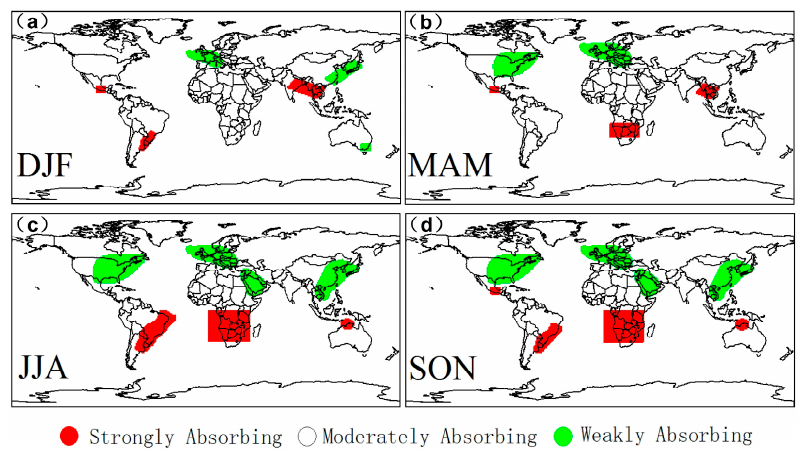
Figure 7. The aerosol types adapted from MODIS C6 Dark-Target (DT) algorithm. ( a – d ) describe the aerosol types in DJF, MAM, JJA, and SON respectively. Remote Sens. 2017 , 9 , 253